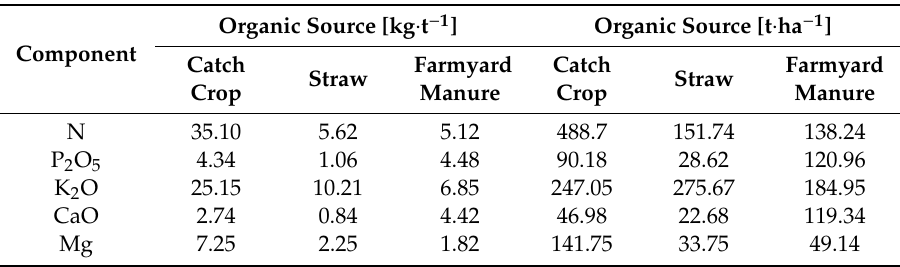
Table 3. Chemical composition of organic sources and the total weight of macroelements applied by organic sources.